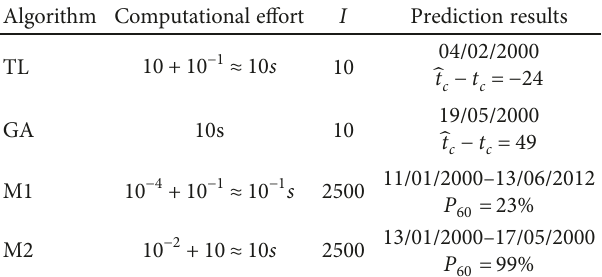
Table 6: Computational e ff ort of the four di ff erent algorithms. Algorithm Computational e ff ort I Prediction